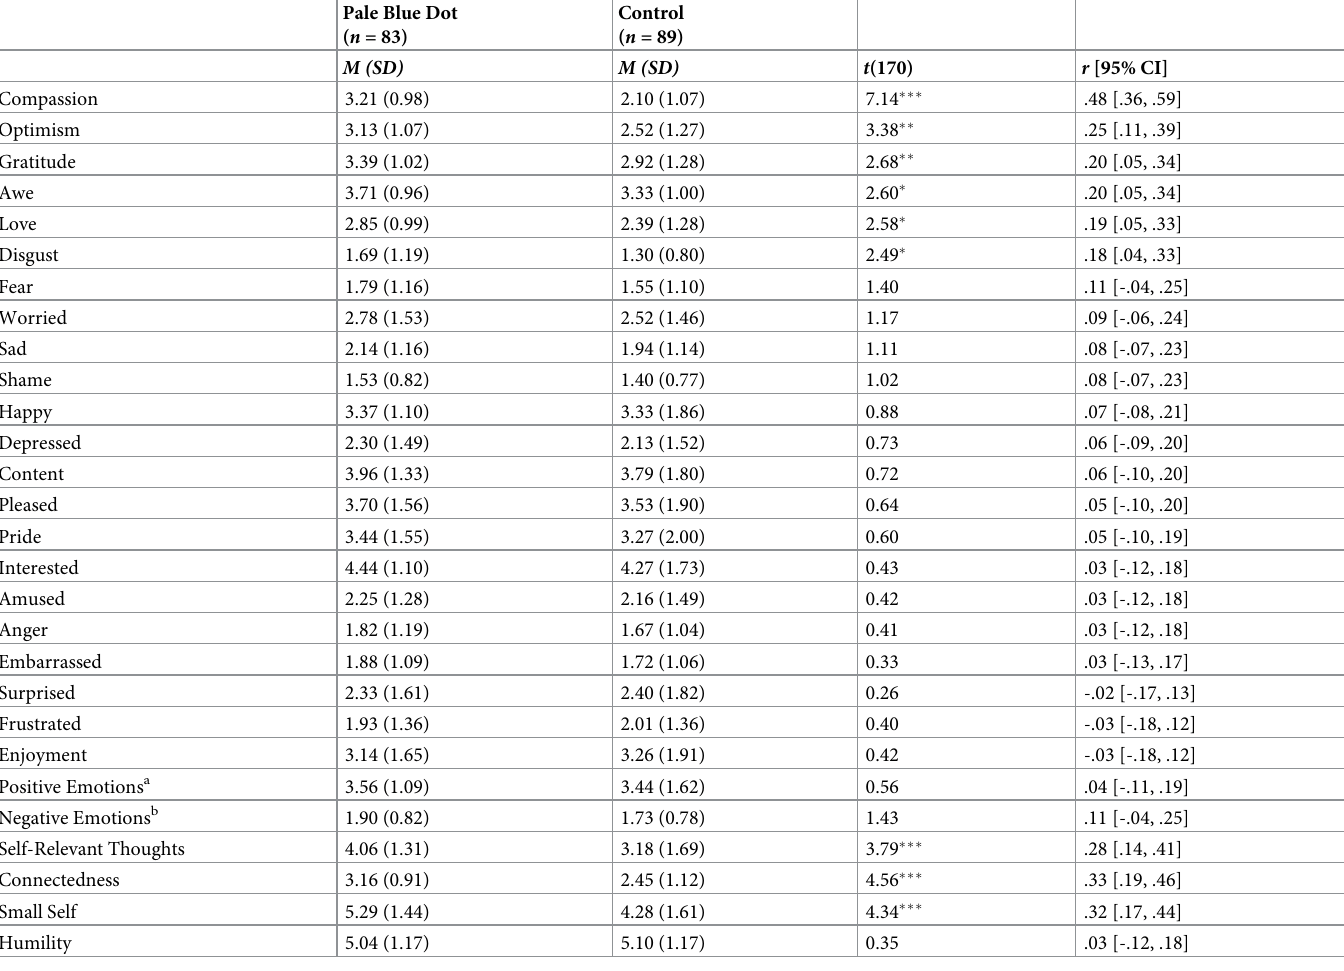
Table 4. Main effects of pale blue dot (via video) on emotions, self-relevant thoughts, connectedness, and humility (Study 2). Pale Blue Dot ( n =